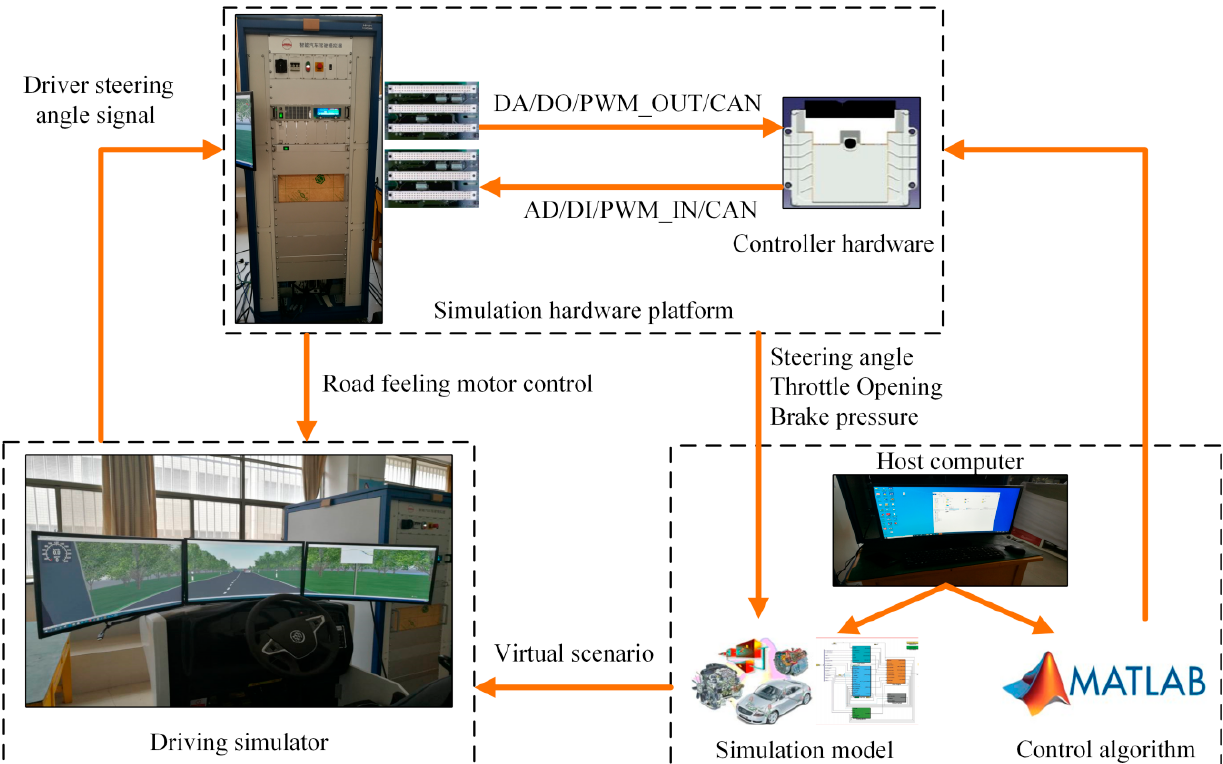
Figure 10. DIL test hardware platform.